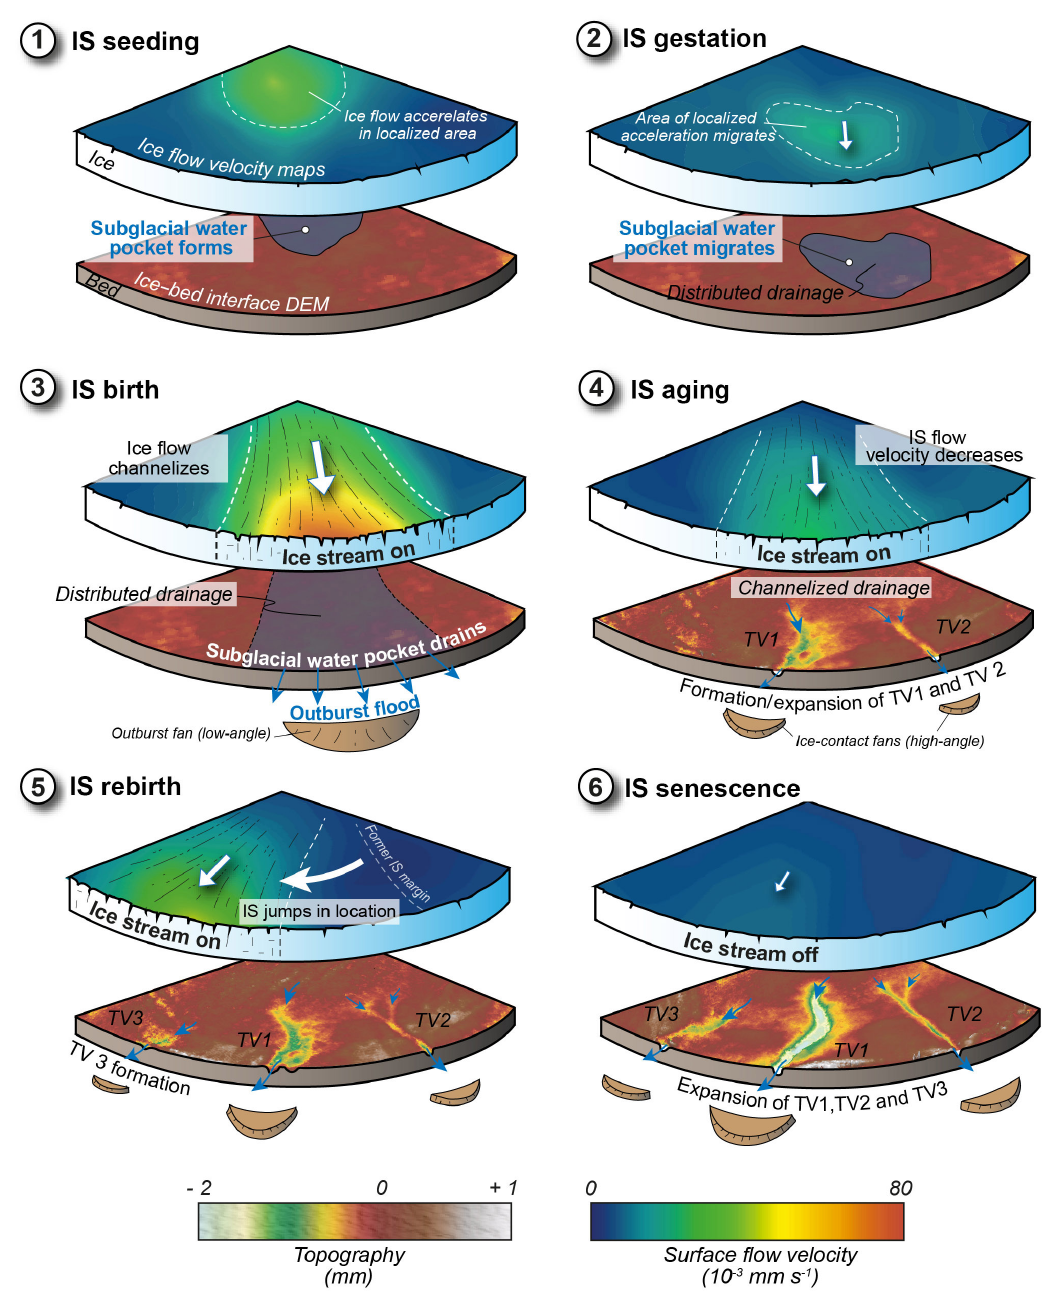
Figure 6. Chronological sequence with interpretative sketches illustrating the proposed ice stream life cycle and the relations with tunnel valley development. Basal topography and surface flow velocity maps are derived from the